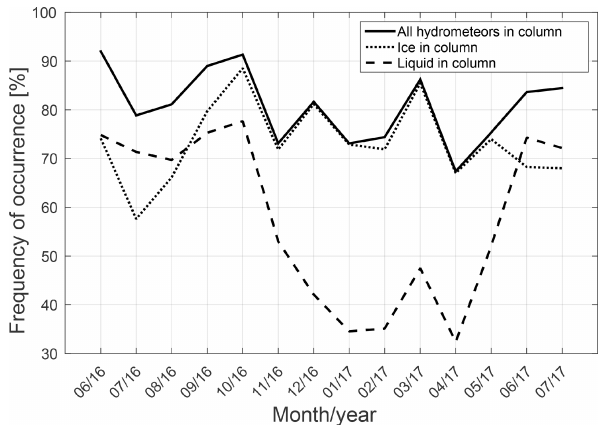
Figure 7. Frequency of occurrence of profiles with ice, liquid, and any kind of hydrometeor. The frequency is given in % and normal- ized to the total number of Cloudnet profiles for each